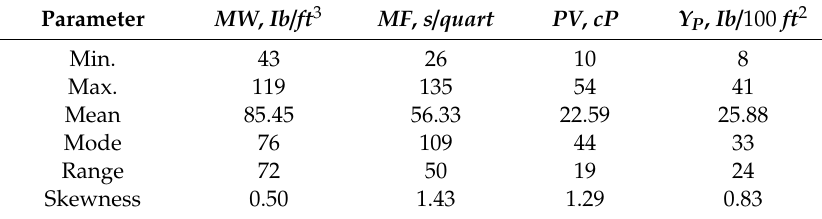
Table 2. Statistical Analysis of the CaCl 2 brine-based mud collected data.